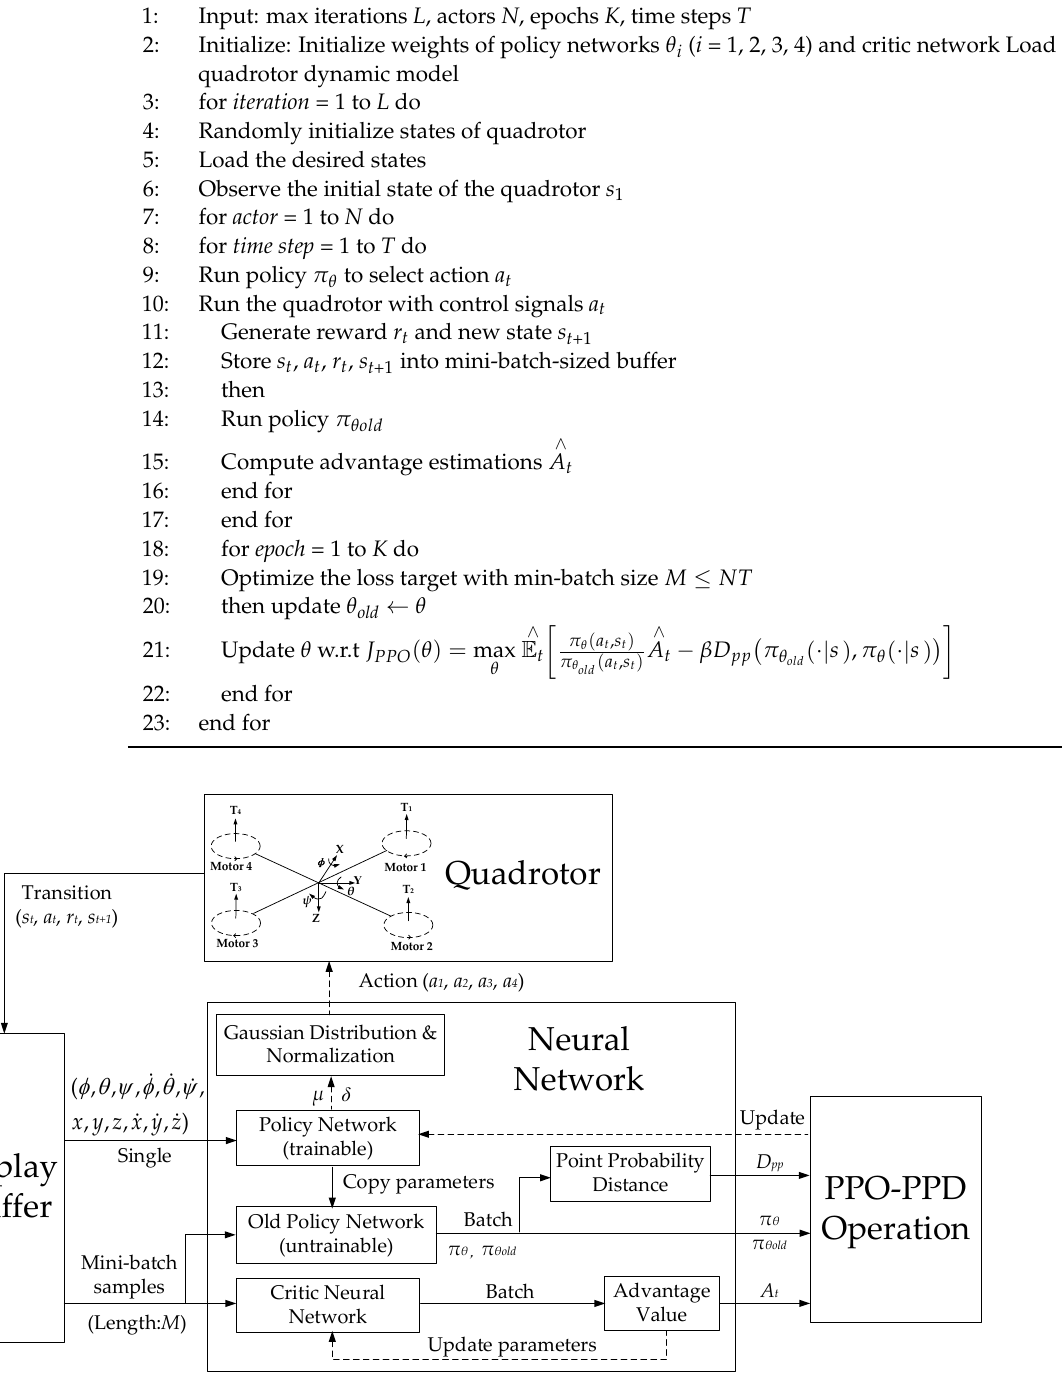
Algorithm 1 PPO-PPD